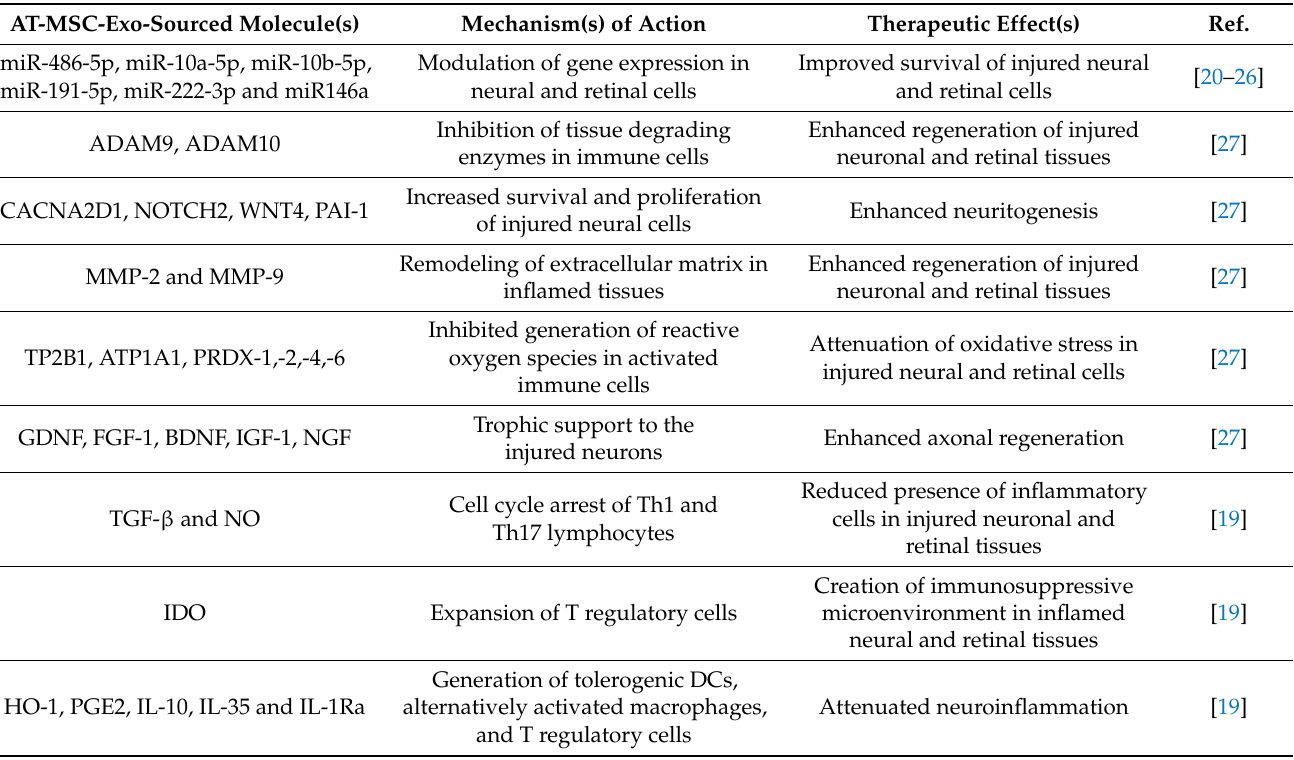
Table 1. AT-MSC-Exo-sourced molecules responsible for therapeutic effects of AT-MSC-Exos in the treatment of neurological and retinal